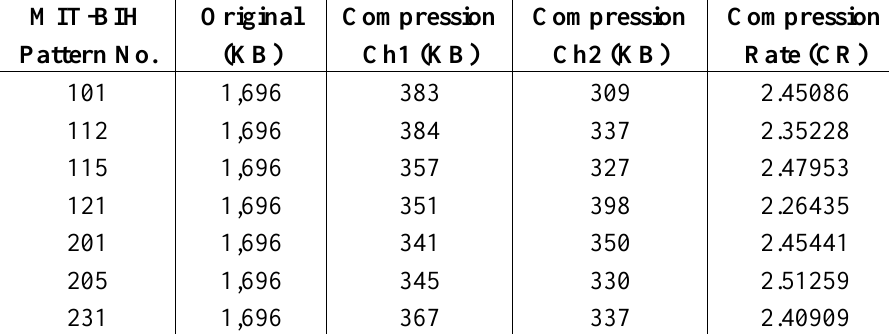
Table 2. The Data Encoder Compression